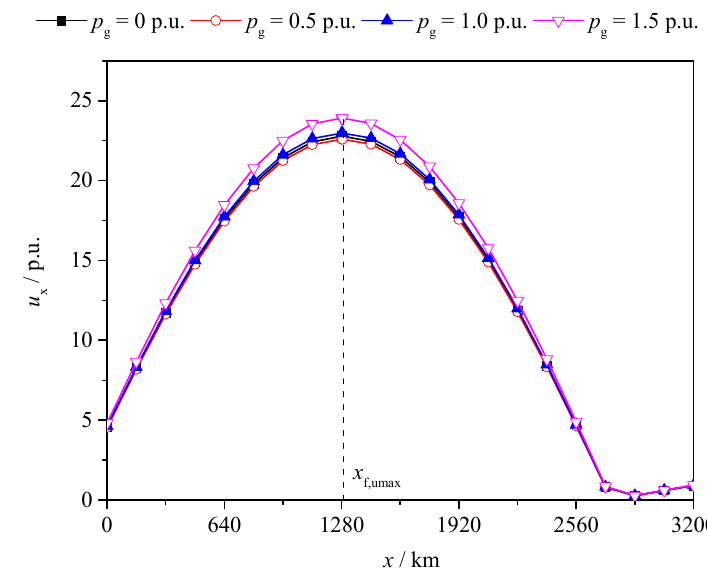
Figure 8. Voltage profile under the three-phase short circuit fault at l fmax .